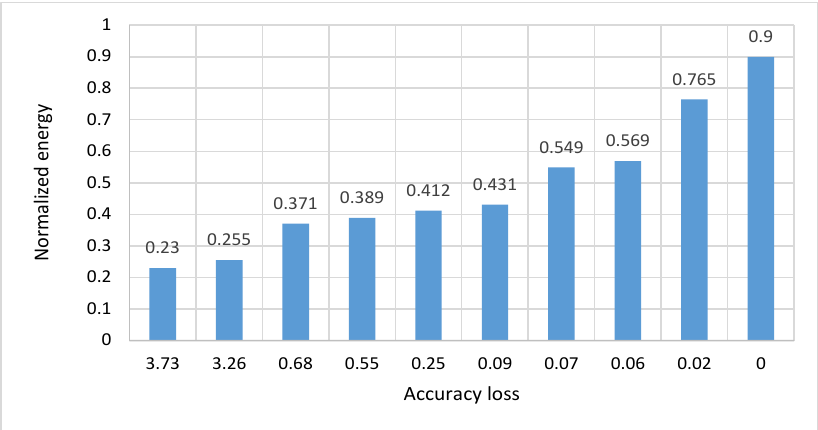
Figure 11. MNIST: Energy levels that the proposed EANN system uses to adapt to the given energy